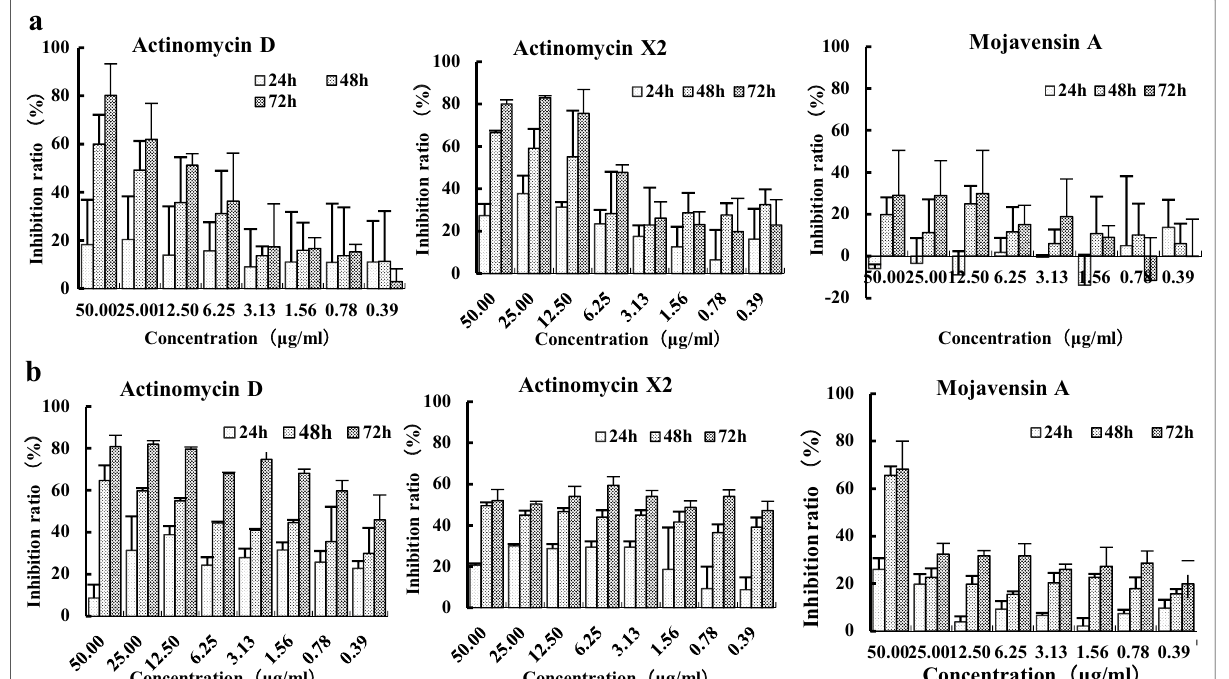
Fig. 5 The cytotoxicity (MTT ASSAY) results of compounds on HepG-2cells ( a ) and CNE-2 cells ( b ) at the different concentrations for 24–72 h